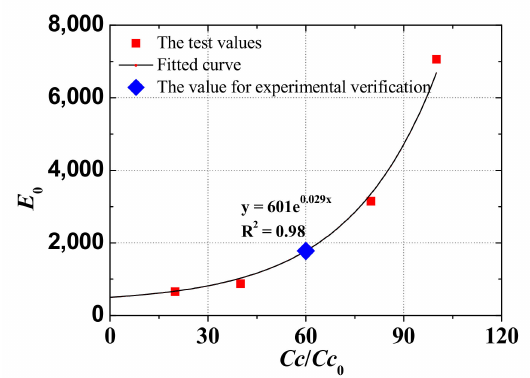
Figure 5. The relationship between the initial modulus E i and confining pressure σ 3 under varying cement contents.